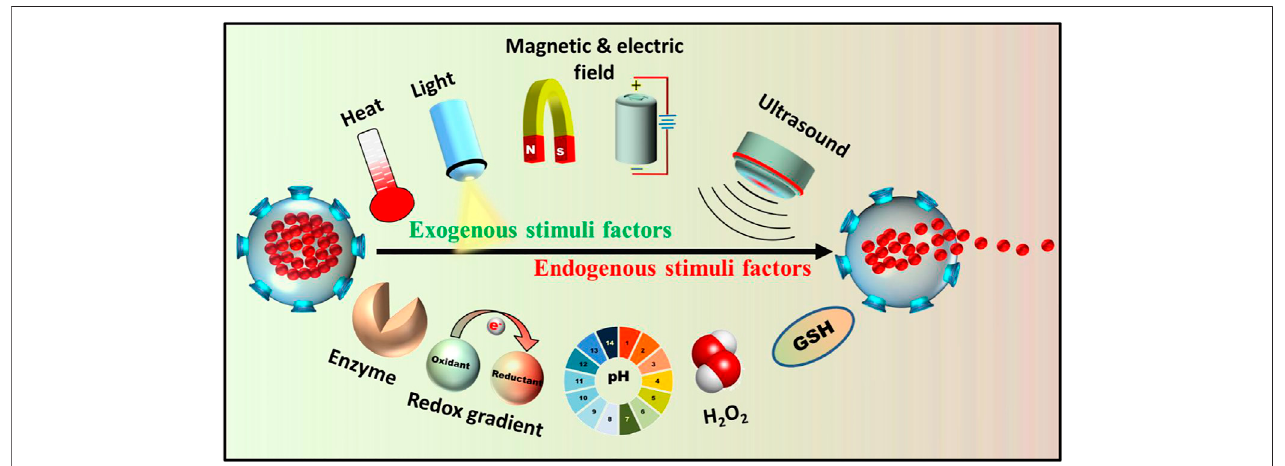
FIGURE 3 | Different type of stimuli responsive drug delivery of antimicrobial